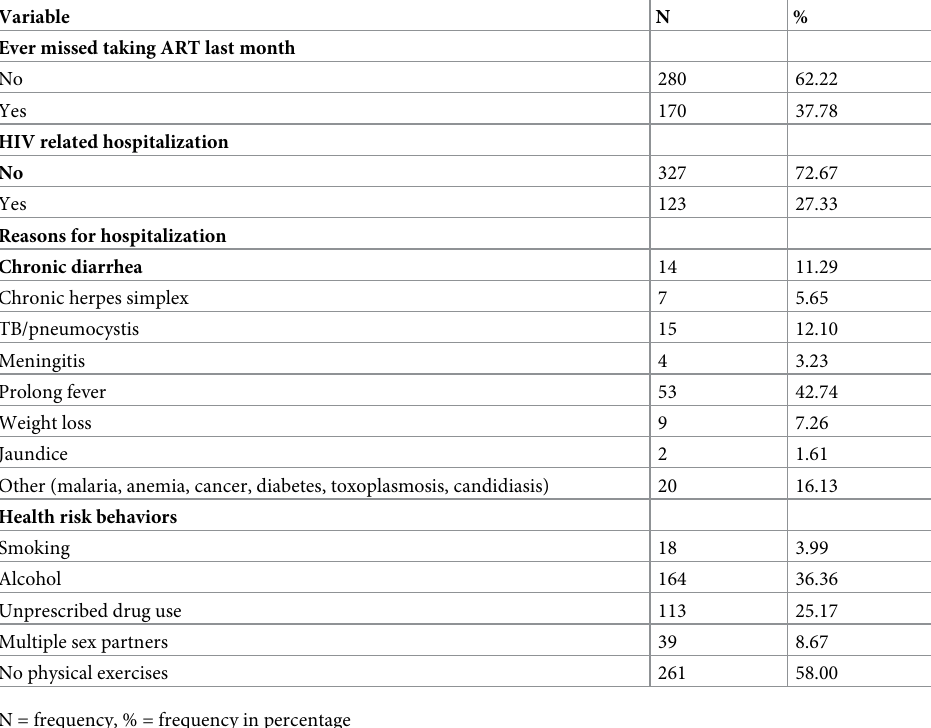
Table 2. ART adherence, health risk behaviors and HIV related hospitalizations among